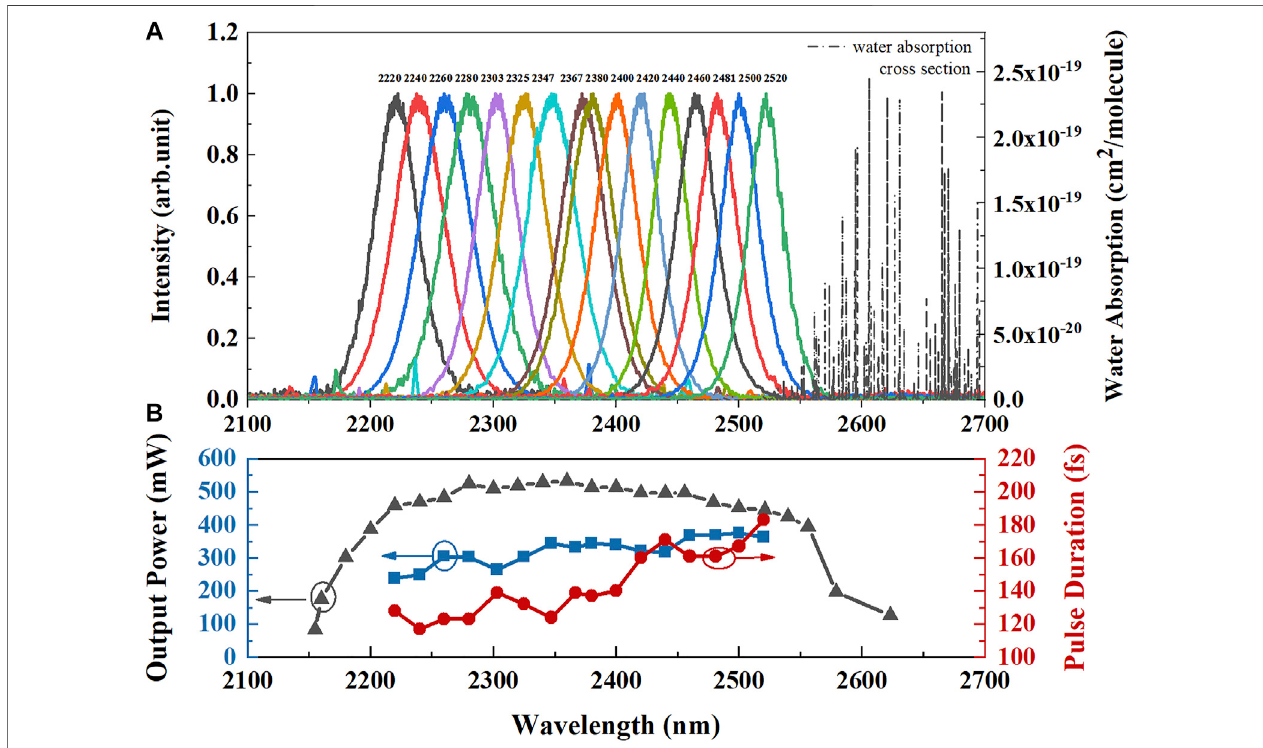
FIGURE 6 | Measured details with the tuning of the central wavelength of KLM laser. (A) Various mode-locked optical spectrums at different tuning wavelengths (solidlines)and water absorption lines (dash lines). (B) CW output power (graytriangle), CWMLoutputpower (blue square), and pulse duration(red circle)versuscentral